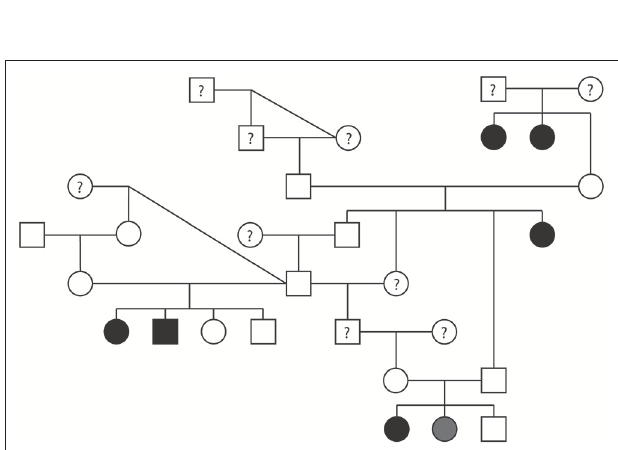
FIGURE 6 | Pedigree representing an extended family of 29 Bulldogs phenotyped for pulmonic stenosis (PS). Affection status is represented as follows: squares represent males, circles represent females, open symbols are PS unaffected, gray symbols are PS equivocal, black symbols are PS affected, and symbols with questions marks have unknown PS cardiac